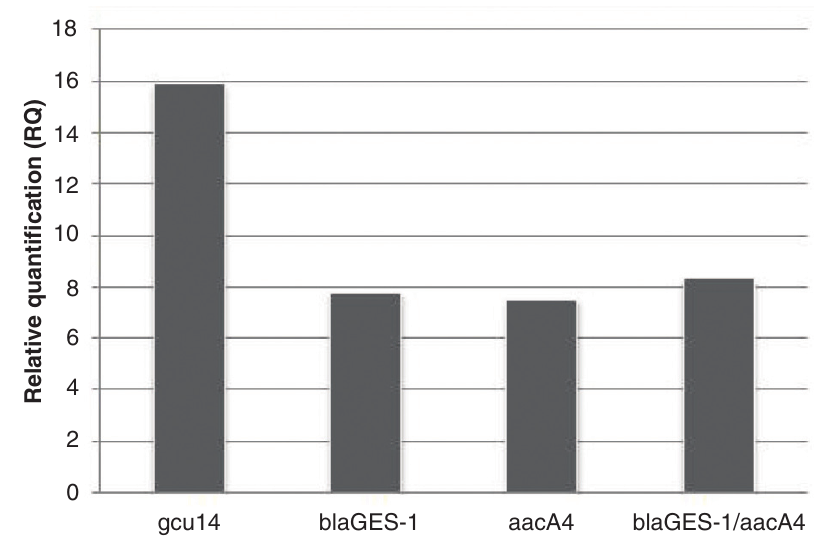
Figure 4. Transcription level of gcu14 - bla are indicated for each gene cassette and for the fusion bla